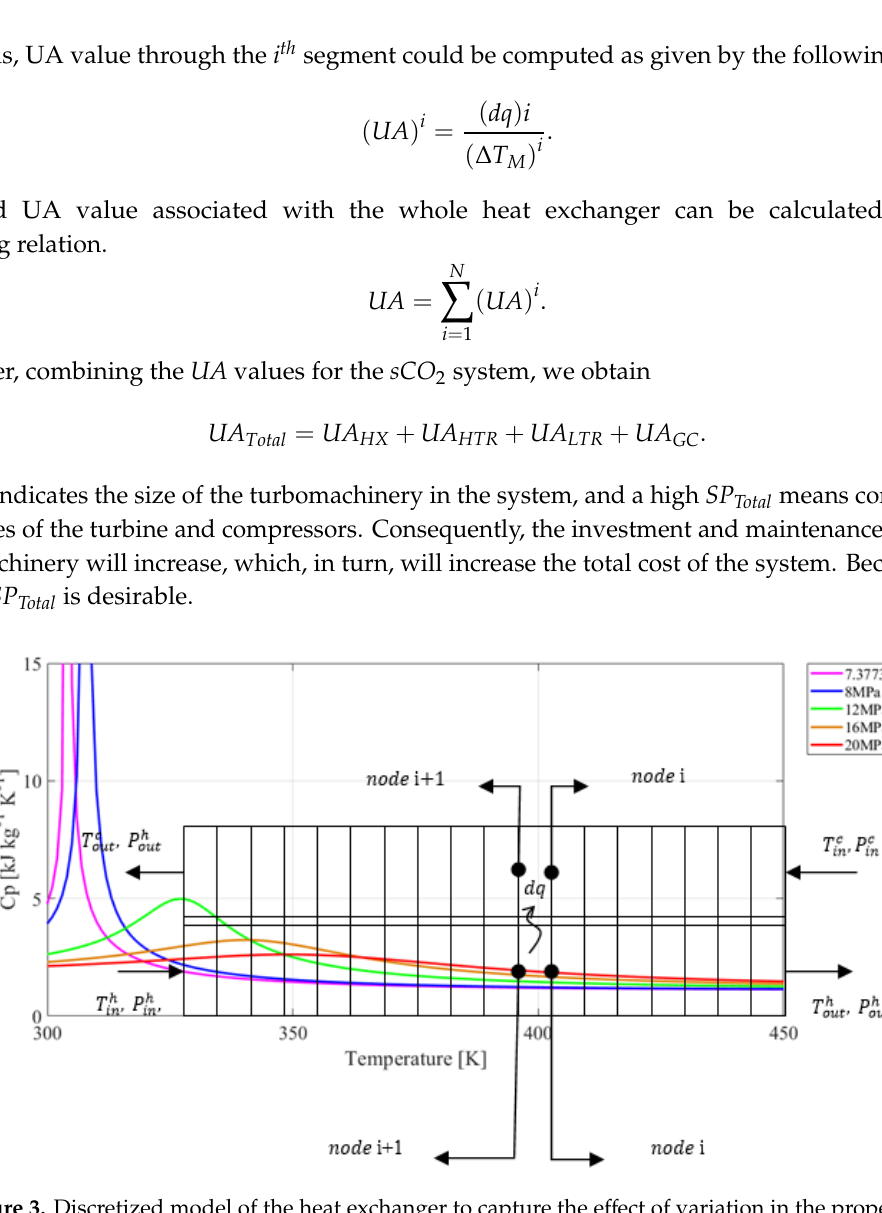
Figure 3. Discretized model of the heat exchanger to capture the e ff ect of variation in the properties of sCO 2